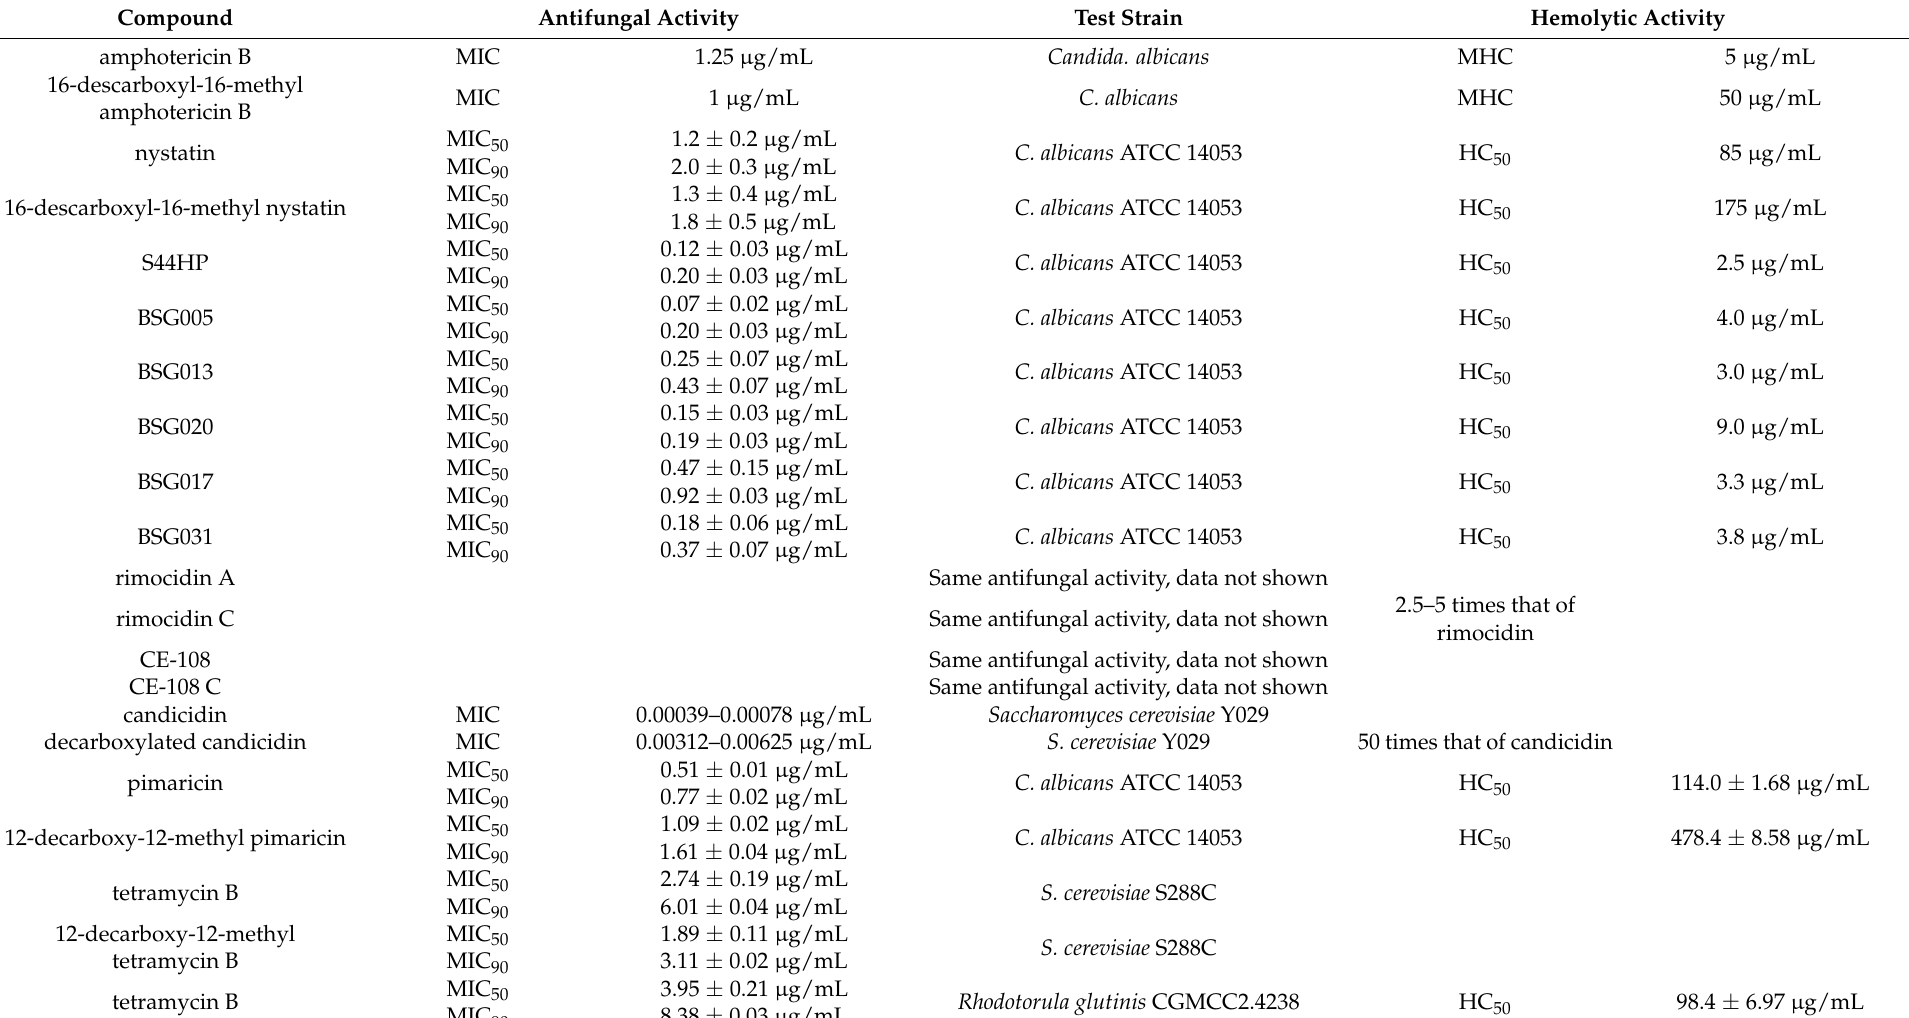
Table 1. The antifungal activity and hemolytic activity of the polyene macrolide and their derivatives